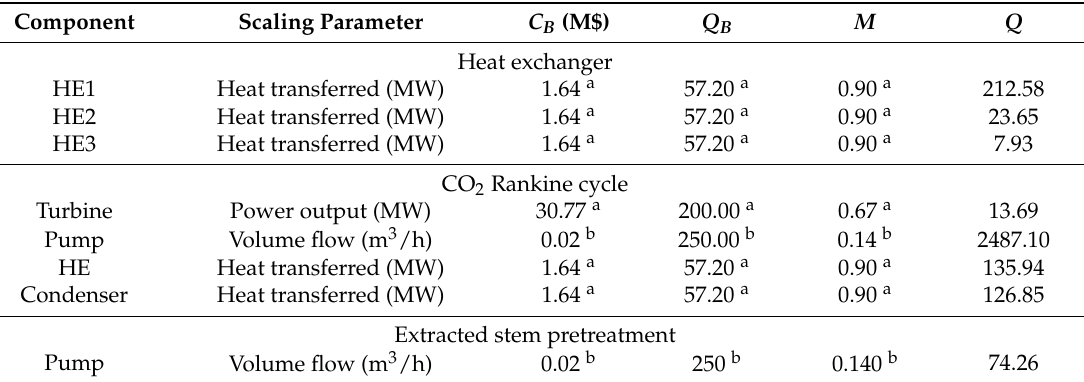
Table 3. Main data for equipment cost estimation.